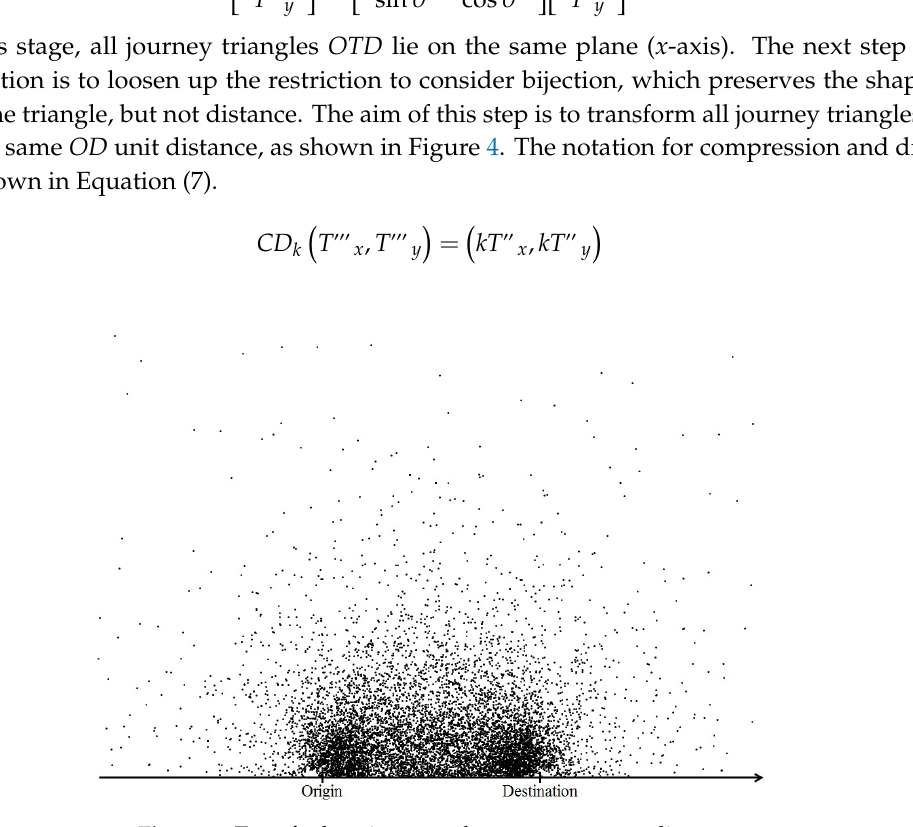
Figure 4. Transfer locations on a homogeneous coordinate.